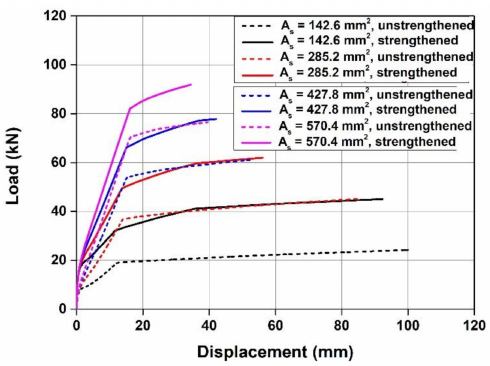
Figure 16. Comparison of load-displacement curves for the different amount of steel